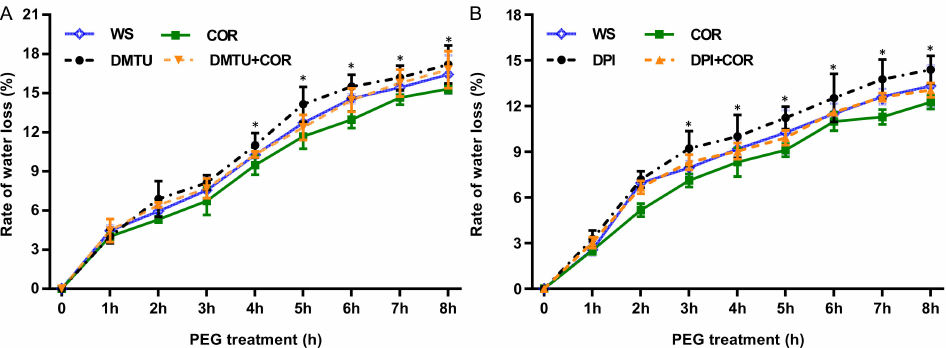
Figure 6. Water loss rate in antioxidants-treated detached maize plants. ( A ) Water loss rate of the pre-treated maize plants with distilled water and COR, subsequently exposed to dimethylthiourea (DMTU) and ( B ) diphenyleneiodo- nium chloride (DPI) for 8 h. Then subjected to 10% ( w / v ) polyethylene glycol (PEG 6000) solution. WS and COR indicated the distilled water-treated and COR-treated plants under PEG treatment conditions, respectively. DMTU/DPI and DMTU+COR/DPI+COR indicate the DMTU/DPI-treated and DMTU+COR/DPI+COR-treated plants under PEG treatment, respectively. The experiments were repeated three times with similar results. Each data point represents mean ± SE ( n = 6), asterisks indicate significant differences ( p < 0.05) between COR and DMTU/DPI treatment using Student’s t -test.